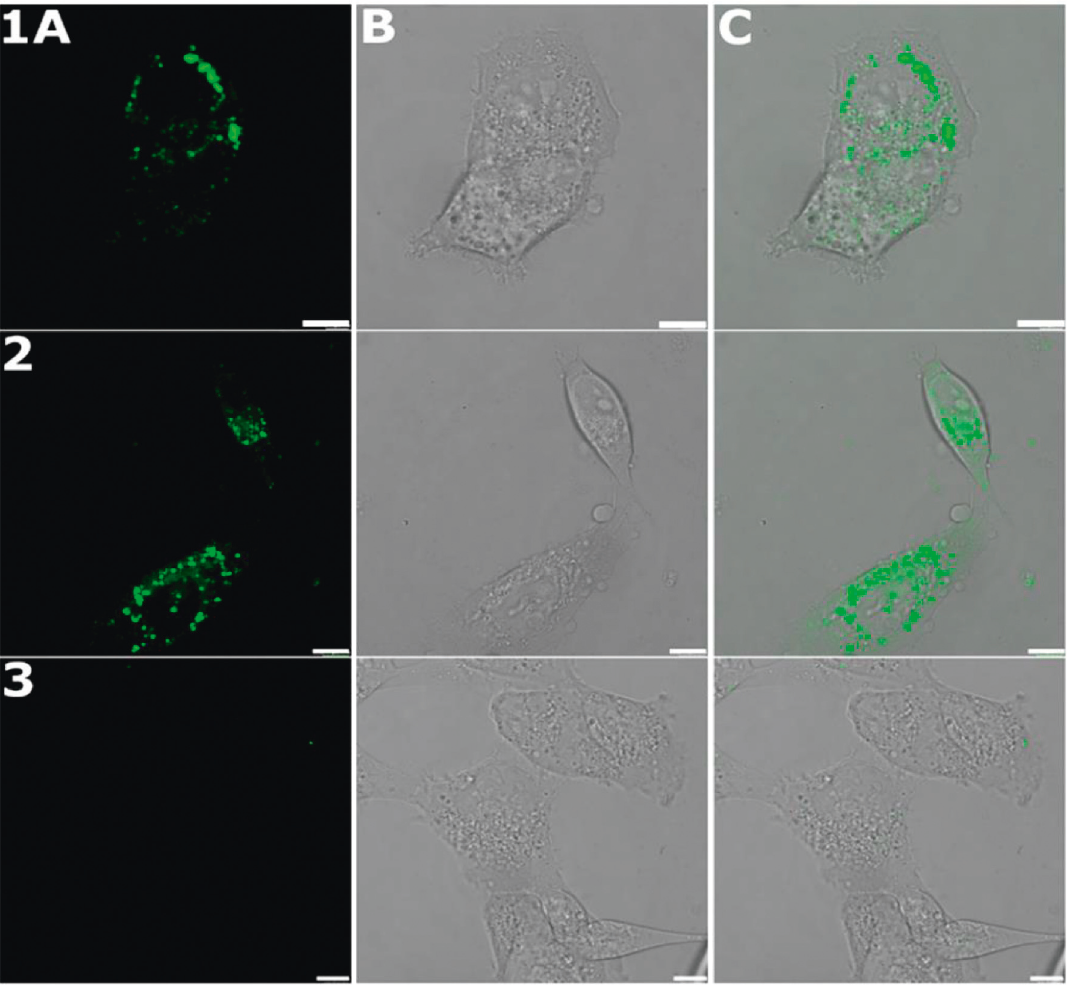
Figure 2: Localization of 1 in RD cells obtained by confocal microscopy. Cells were treated with complex 1 (10 μ M) and incubated for 3h (line 1) or 24h (line 2). Untreated cells (line 3) were included as a control of autofluorescence of RD cells. Images were obtained in fluorescence mode (column A), bright field mode (column B), or overlaid (column C). Scale bars represent 10 μ